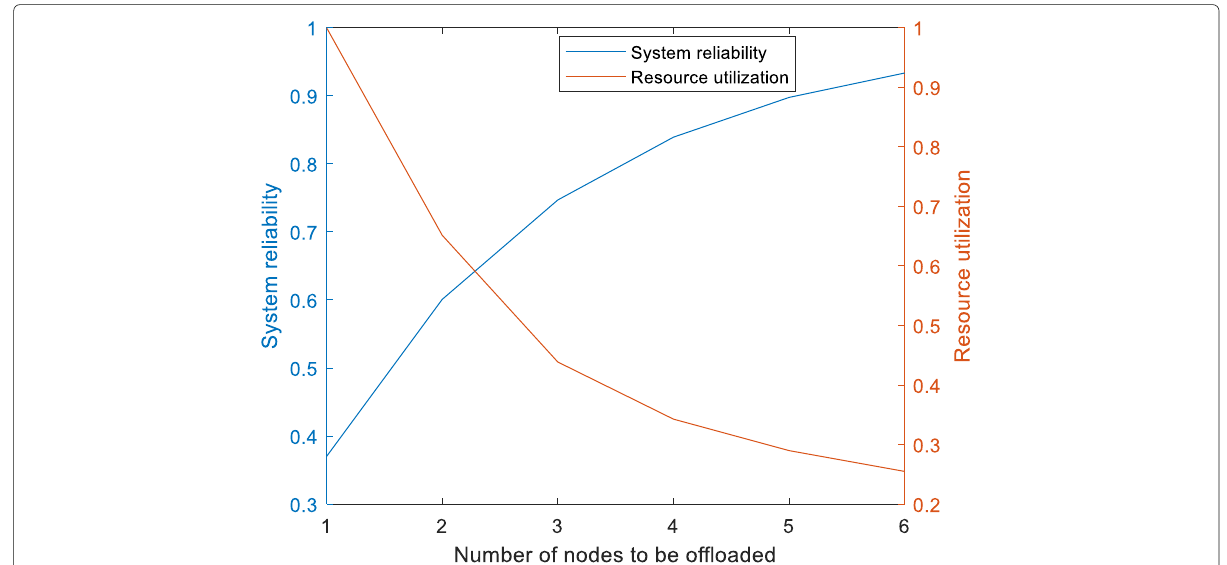
Fig. 12 Resource utilization and system reliability